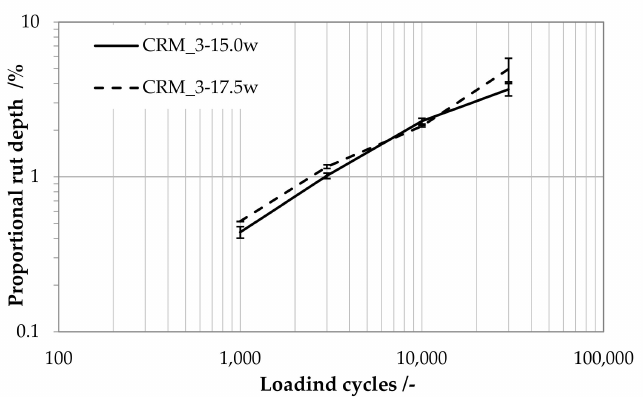
Figure 9. Proportional rut depth as a function of loading cycles at 20 ◦